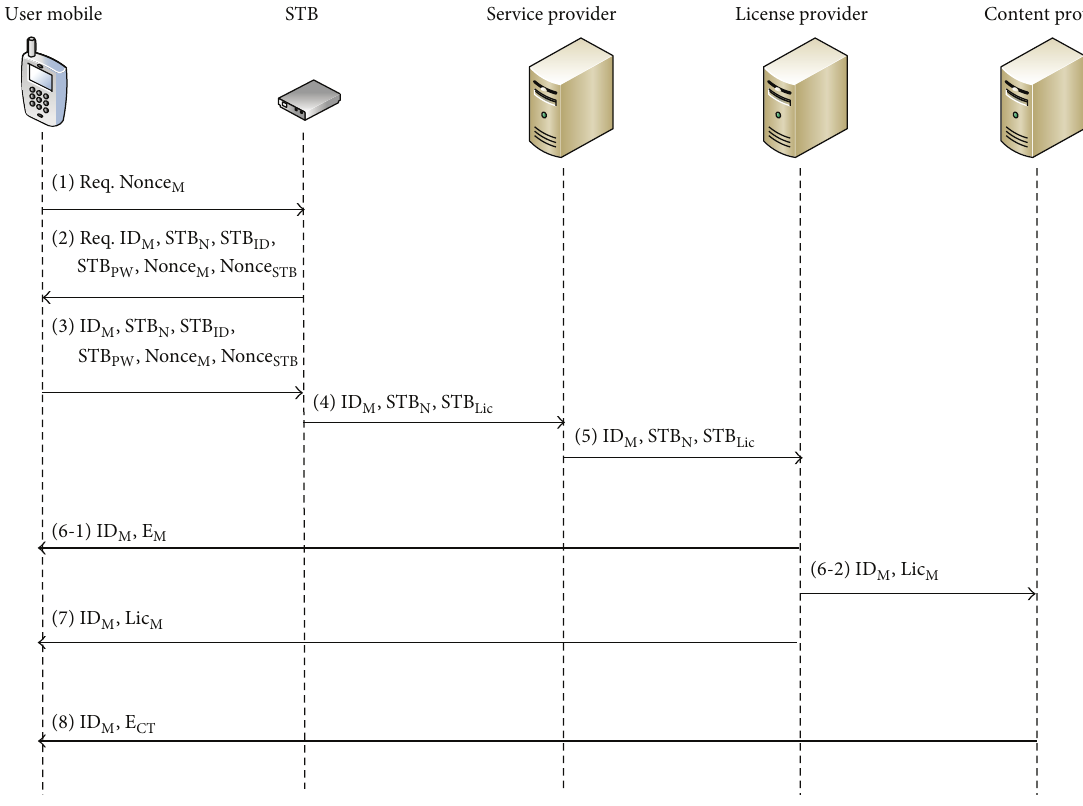
Figure 4: User device registration process to migrate user mobile device to STB through access